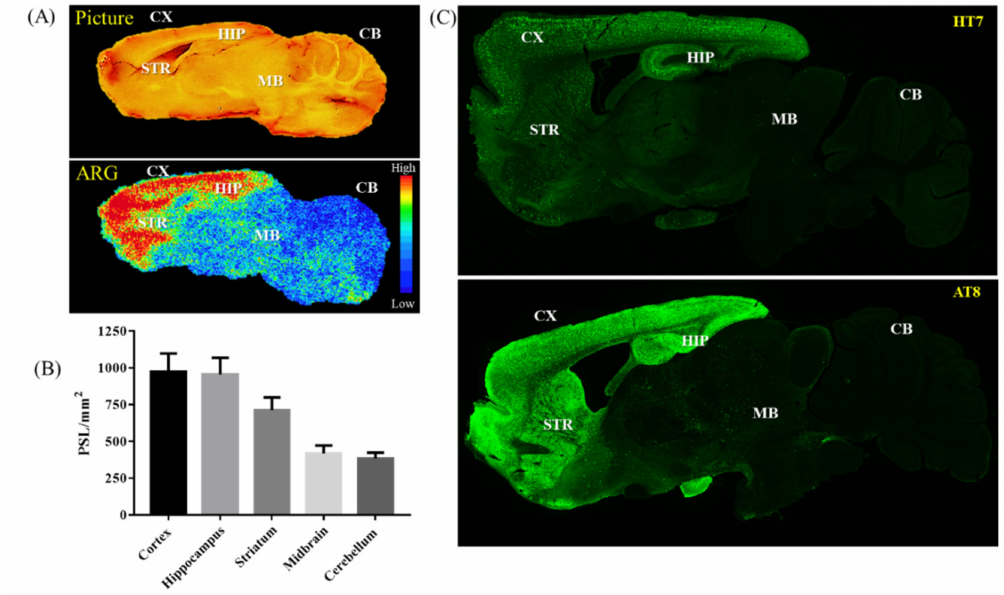
Figure 5. Correlations of 18 F-PM-PBB3 radioactivity distribution with tau immunohistochemical study in 6-mo-old rTg5410 mouse brain sections. ( A ) Representative photograph of the sagittal brain section and its autoradiography. ( B ) Quantitative measurement of radioactivity in di ff erent brain regions of the rTg4510 mouse. ( C ) Neocortical / hippocampal human tau (HT7 antibody) and hyperphosphorylated tau (antibody AT8) immunofluorescent on sagittal brain sections at the level adjacent to the autoradiography study. (CX: cortex, STR: striatum, HIP: hippocampus, MB: midbrain, CB: